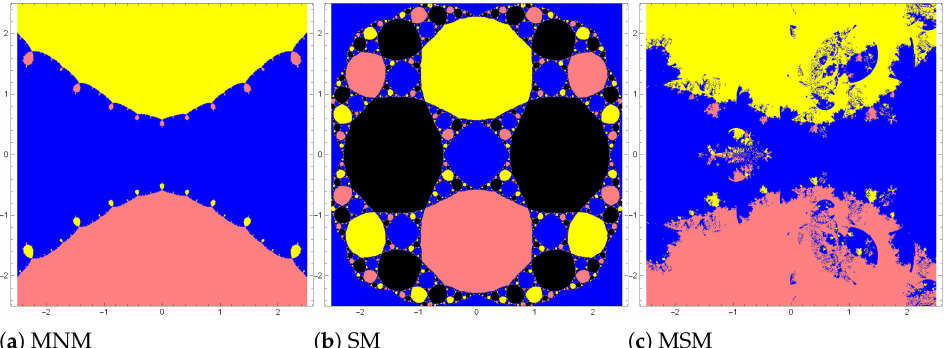
Figure 5. Dynamical planes of new and existing methods for Example